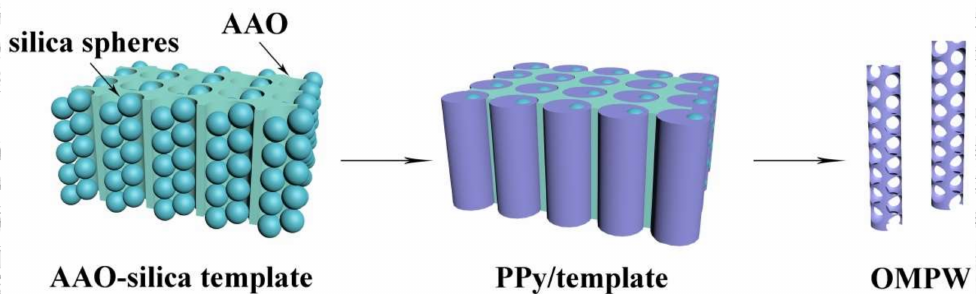
Figure 1. Schematic view of the synthesis route of ordered mesoporous polypyrrole nanowires